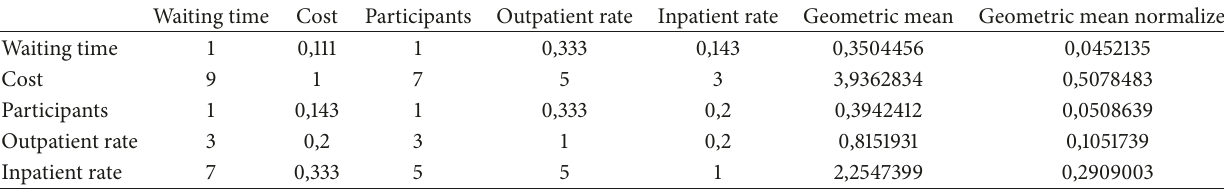
Table 3: AHP: the preferences of the insurer toward the decision